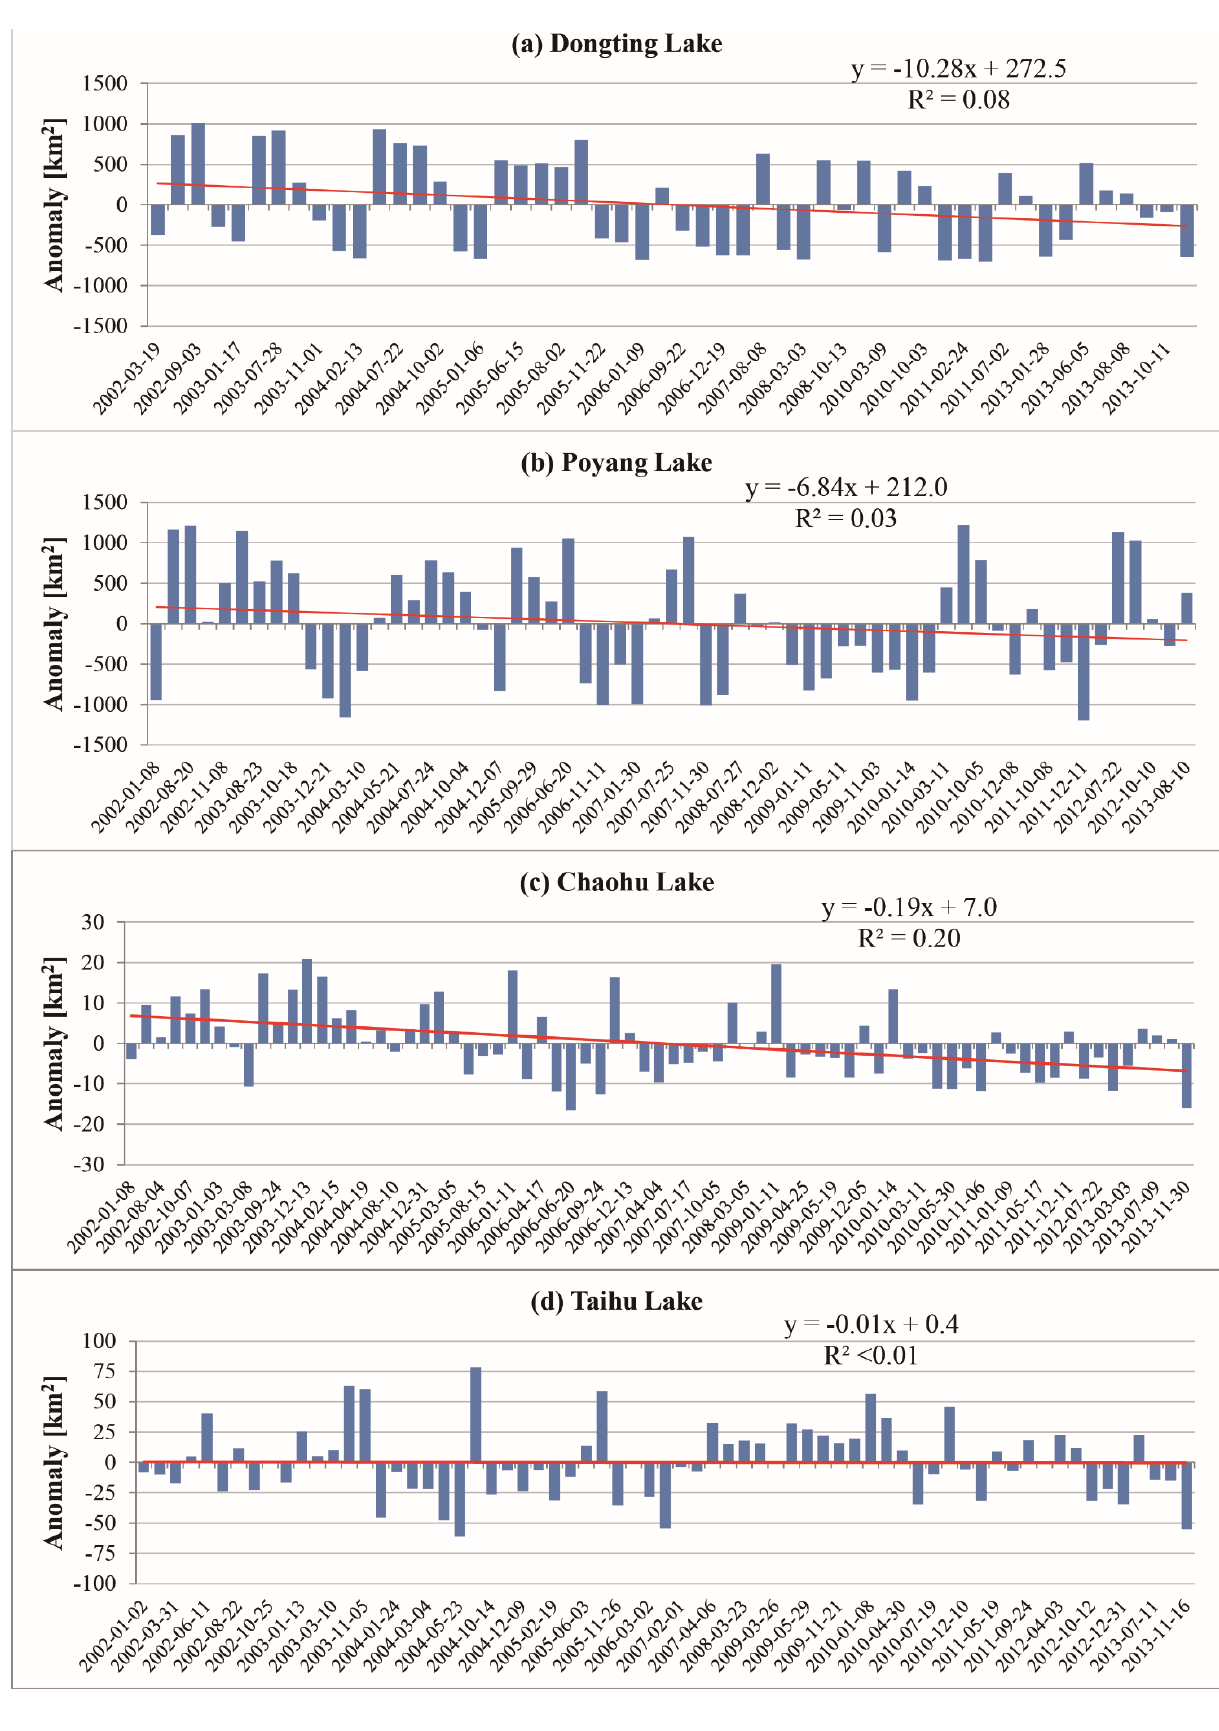
Figure 6. Anomaly of lower Yangtze River lakes from 2002 to 2013 for ( a ) Dongting Lake; ( b ) Poyang Lake; ( c ) Chaohu Lake, and ( d ) Taihu